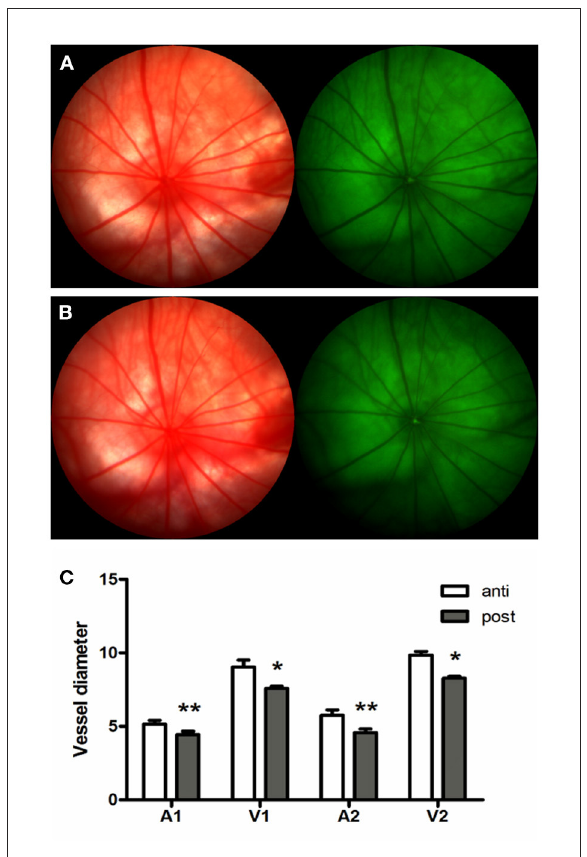
FIGURE4 Hyperoxia induced vasoconstriction in rat retina. (A) Fundus imaging and FFA of rat retina proir to experimental processing. (B) Fundus imaging and FFA of rat retina after consecutive hyperoxia exposure for 7 days. (C) Variation of retinal vessel diameter induced by hyperoxia exposure. * p < 0.05, ** p < 0.01, FFA, Fundus fluorescein angiography; A1 and V1, Arterioles and venules beside the ONH edge; A2 and V2, Arterioles and venules at one time the optic disc